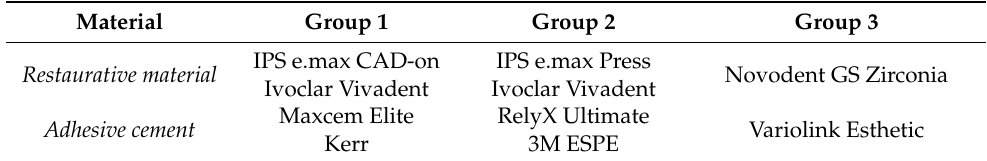
Table 3. Distribution of tooth groups for SEM